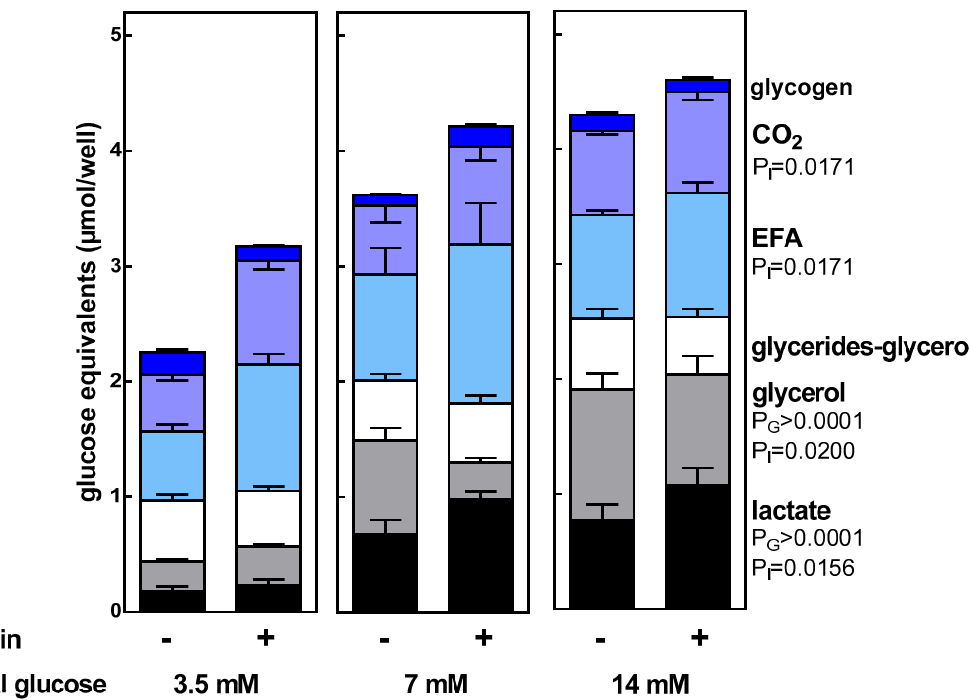
Figure 3. Final distribution of the medium glucose label calculated from the radioactivity incorporated into the different label-containing fractions studied. Lactate and glycerol data correspond to the amount of lactate and glycerol found in the medium; glycerides-glycerol, EFA, and glycogen data were obtained from the cell intracellular content; CO 2 was calculated from EFA values as indicated in Materials and Methods. The data (calculated as glucose equivalents) are presented as mean ± SEM from six different animals. EFA = esterified fatty acids (in the cell lipid droplet). The statistical significance data are the same as in Figure 1. Since CO 2 was directly calculated from the radioactivity found in the esterified fatty acids, the statistical data were similar to that of EFA.